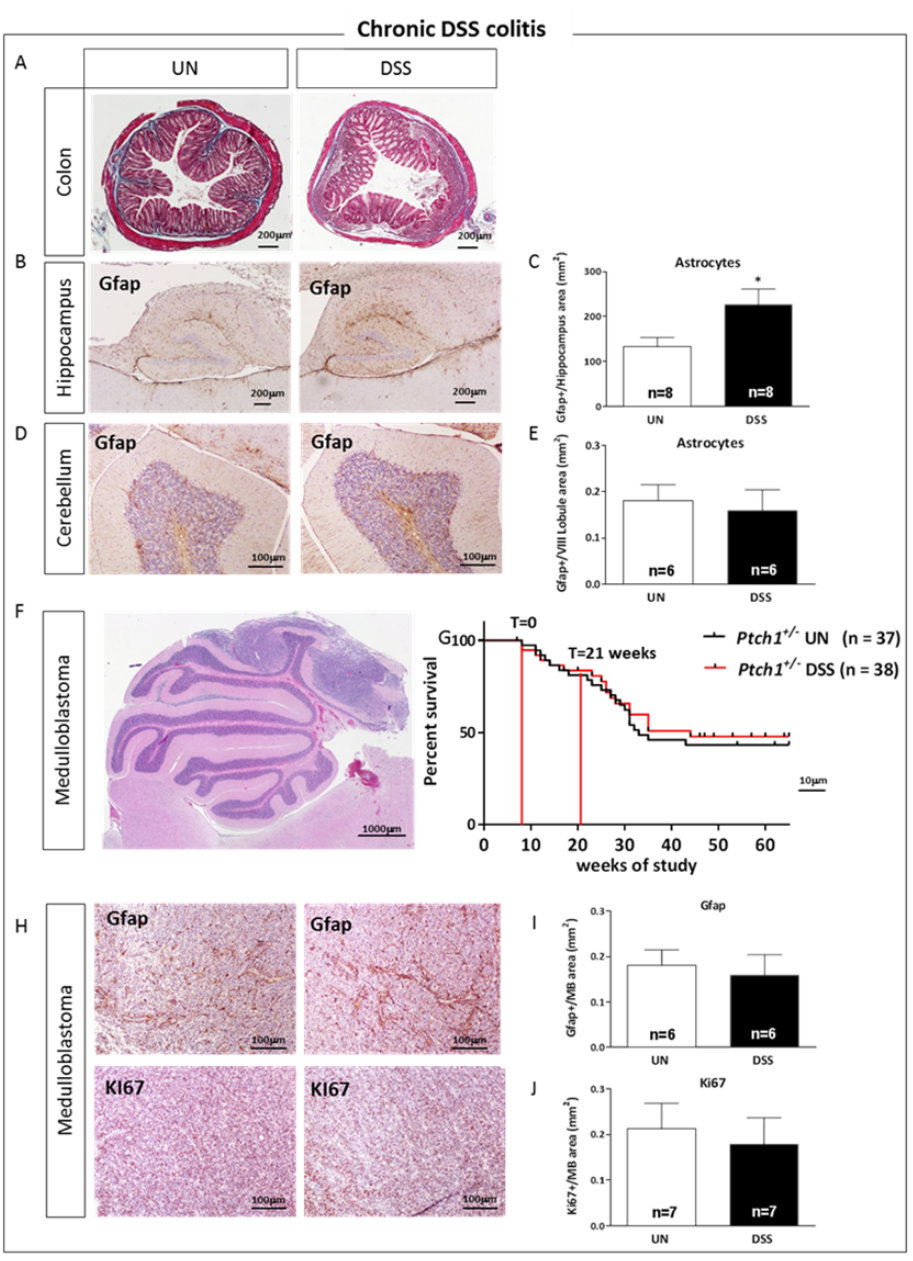
Figure 8. Gut inflammation and brain tumorigenesis relationship in Ptch1 +/ − /C57BL6 mice. ( A )